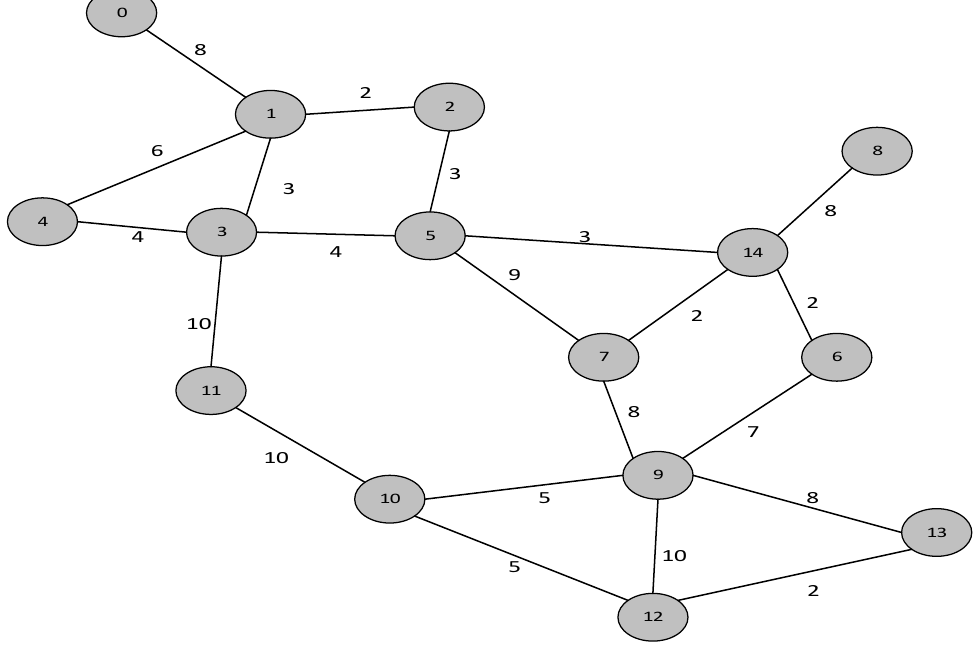
Figure 1. The Swiss road network by Mandl [25].